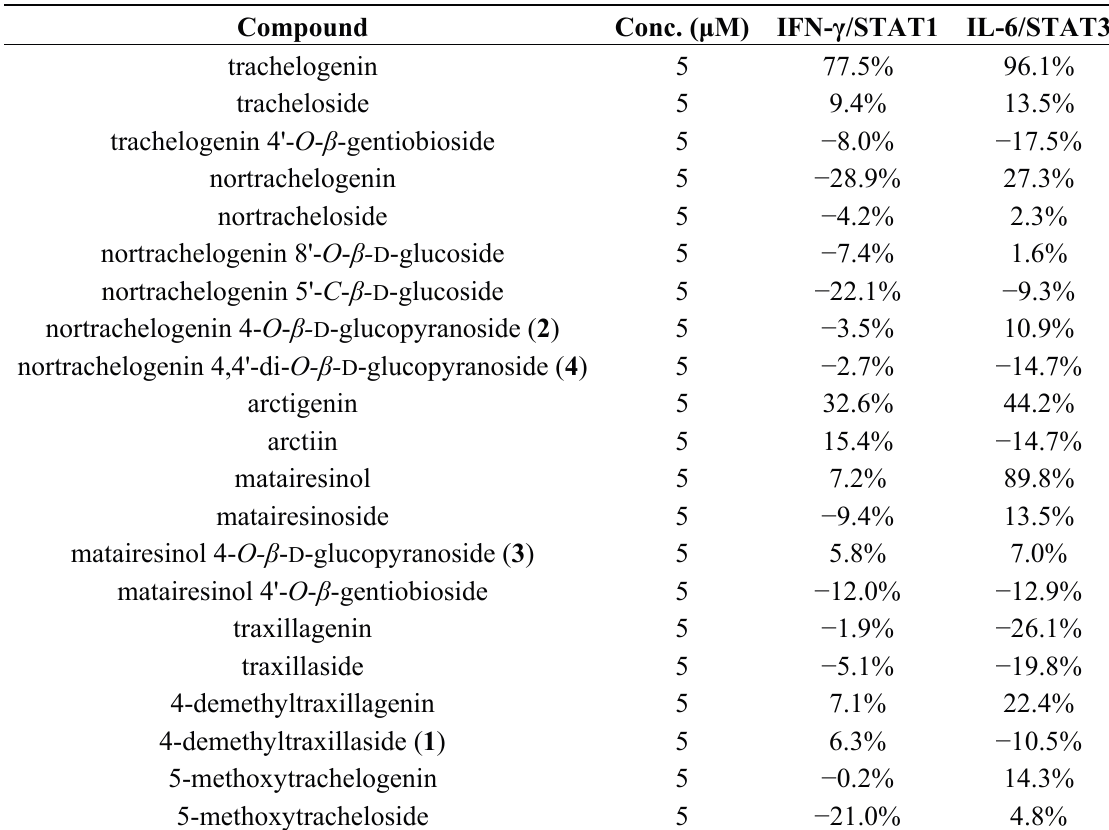
Table 3. Inhibition ratio (IR%) values of lignan components from Caulis Trachelospermi on IFN- γ /STAT1 and IL-6/STAT3